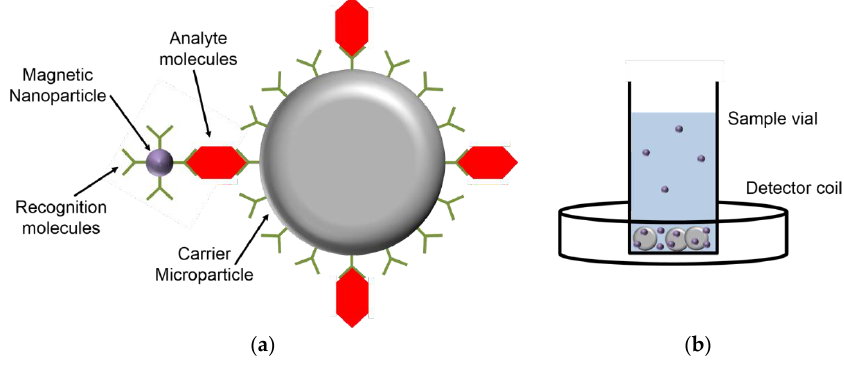
Figure 1. Schematic measurement principle of the magnetic permeability sensing method: ( a ) Magnetic nanoparticles (NPs) and carrier microparticles with recognition molecules on the particle surfaces bind via analyte molecules; ( b ) The microparticles sediment, resulting in an analyte-concentration dependent magnetic NP concentration at the bottom of the sample vial, which is placed in the center of the detection coil for determining its magnetic permeability.